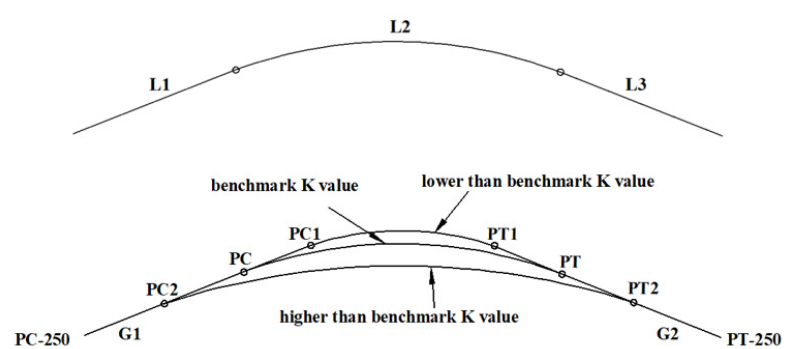
Figure 1. Schematic diagram of the grade change point section.